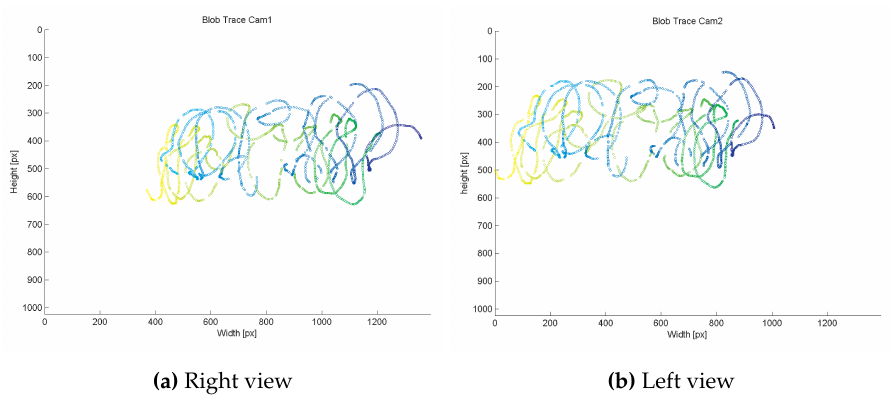
Figure 20. Corresponding blob traces used for extrinsic calibration.